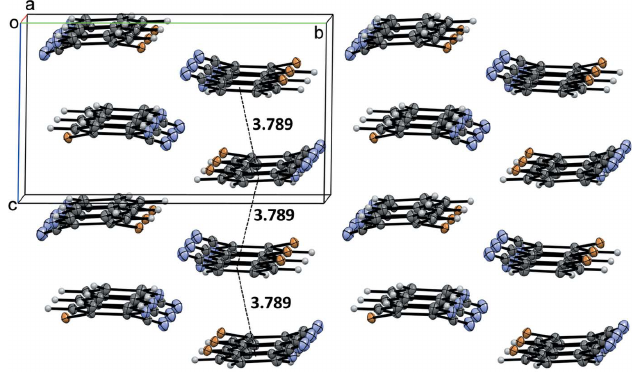
Figure 3 Packing diagram of the title compound showing the (cid:2) – (cid:2) stacking interactions (dashed lines). Displacement ellipsoids are drawn at the 30% probability